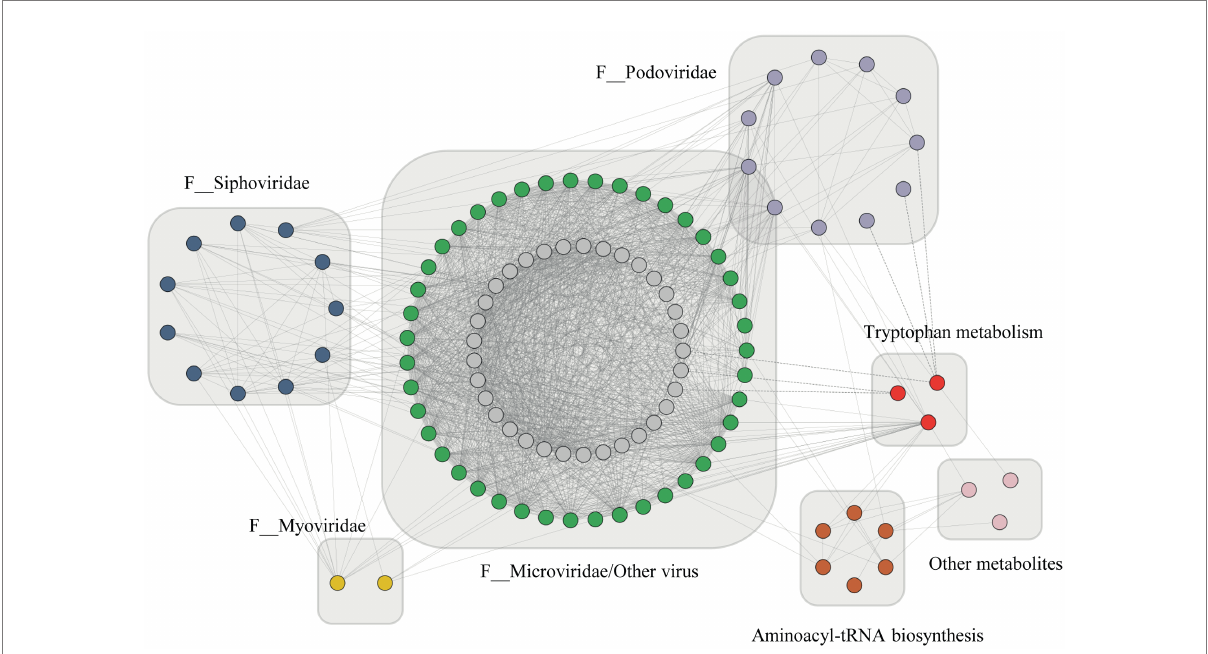
FIGURE 5 Co-occurrence network between the differential virome and metabolites with Spearman’s rank correlation coefficient (|r|>0.6, p < 0.01). Viruses were shown in blue, green, yellow, purple, and gray dots and metabolites were shown in red, orange, and pink. Solid lines indicate positive correlations, and dashed lines represent negative